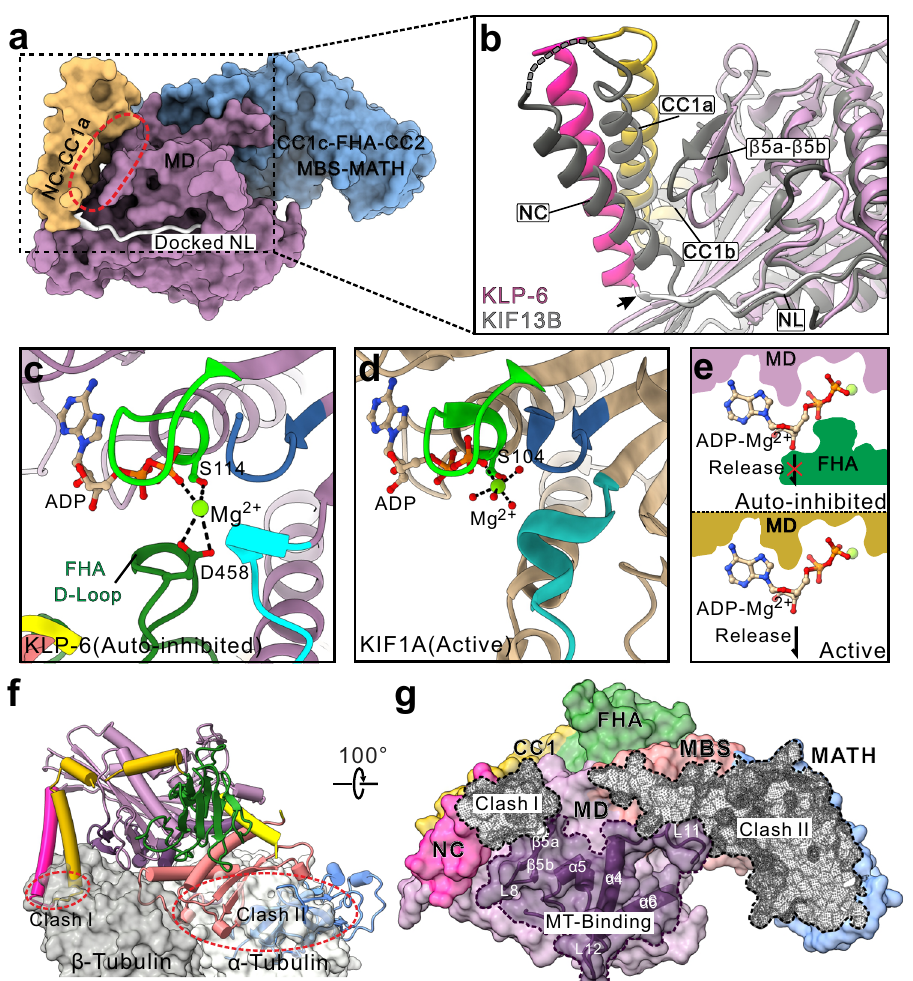
Fig. 3 | Multilevel lockdown of KLP-6 for autoinhibition. a , b CC1-mediated lockdown of the neck domain. A combined surface and ribbon representation showing that the NL is locked in a docked state on the MD ( a ). Structural com- parison of the N-terminal fragment of KLP-6 with that of KIF13B ( b ). In this com- parison, theMD-NC-CC1tandemof KIF13B(PDBcode:6A20)is colored ingrayand the similar fragment of KLP-6 is colored as panel a . The NL of KLP-6 is one-residue longer than that of KIF13B (indicate by a black arrow). c – e The D-loop of the FHA domain traps ADP-Mg 2+ in the nucleotide-binding pocket. A close-up view of the nucleotide-bindingpocketintheMDofKLP-6( c )andthatofKIF1A(PDBcode:1I5S) ( d ). ADP are shown as sticks and Mg 2+ are shown in spheres. The interactions with Mg 2+ in the nucleotide-binding pocket are highlighted by dashed lines. The P-loop